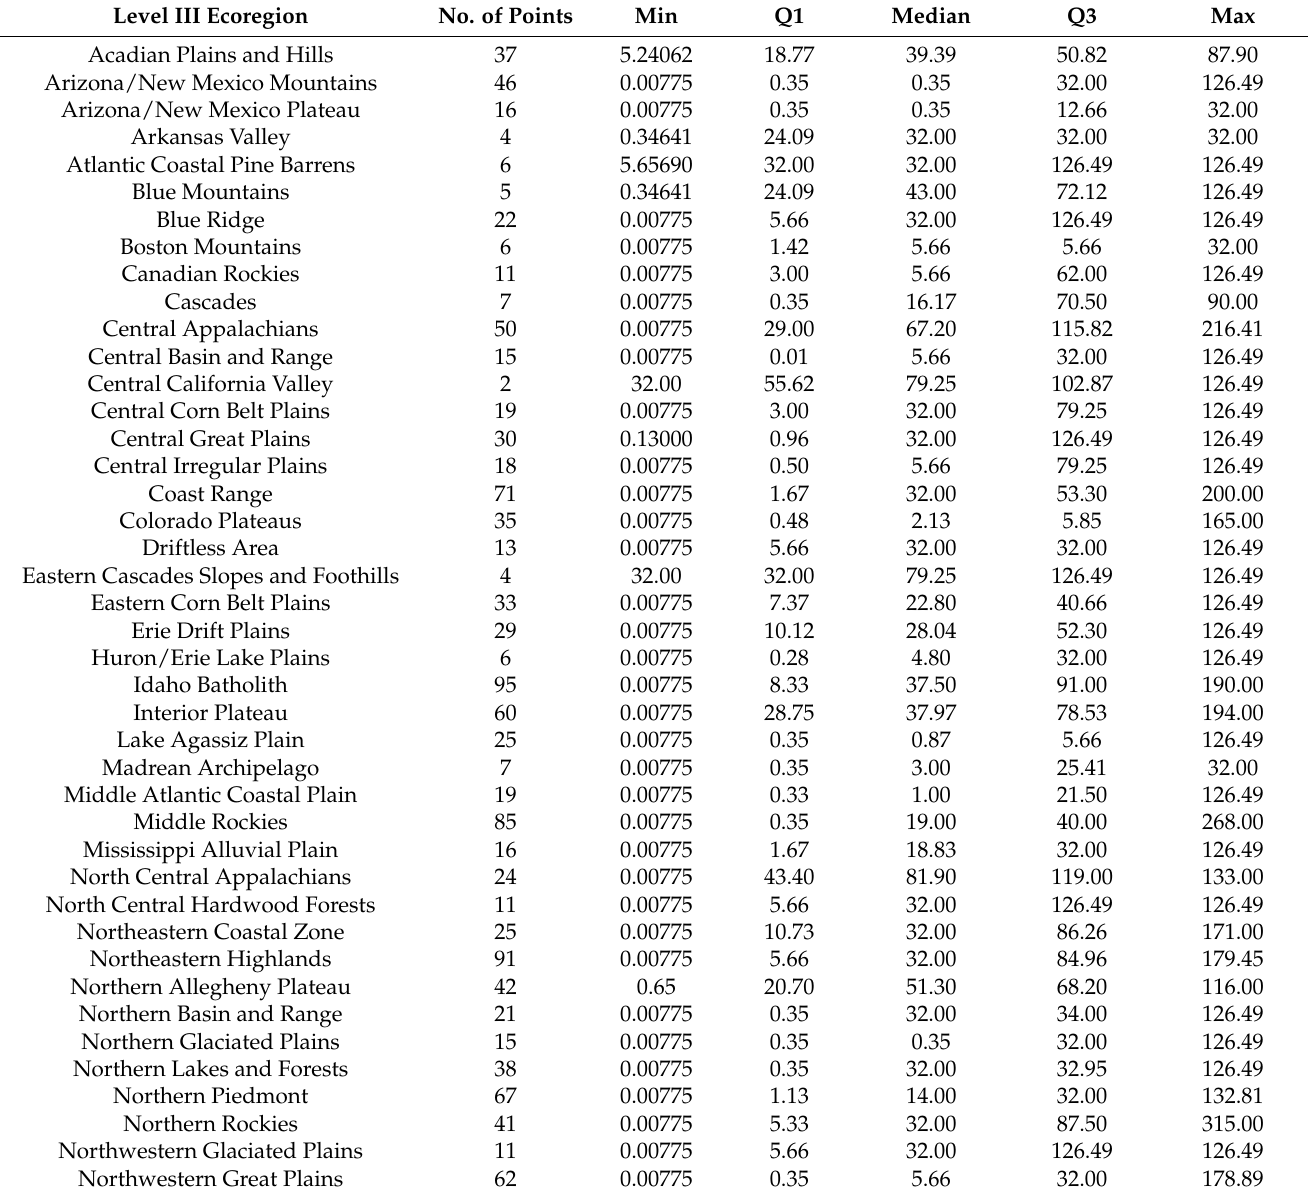
Table A1. D50 data distribution per Level III